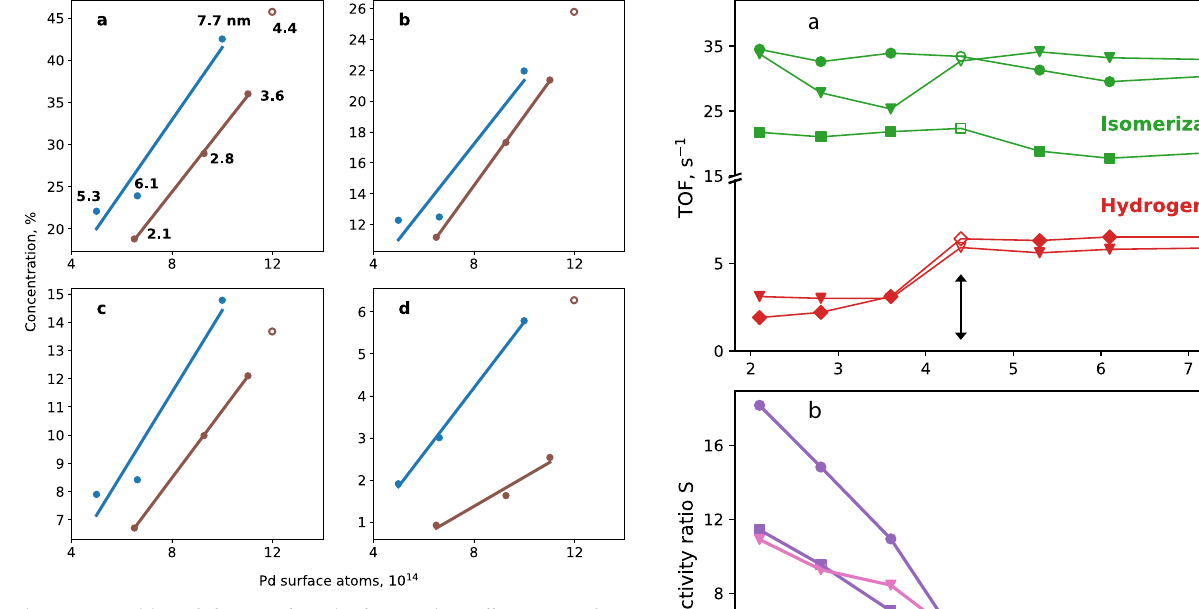
Fig. 3 Composition of the gas phase in the reaction cell at 373 K after 10 min. Isomerization and hydrogenation of 1-butene on various Pd/Al 2 O 3 / NiAl(110) model catalysts, over NPs with smooth (blue) and rough (brown) surfaces; average particle diameters (nm) indicated in panel a . Shown are the fractions (in percent) as a function of the total number of Pd surface atoms: a converted reactant 1-butene, as well as products b trans-2-butene, c cis-2-butene, and d n-butane; see also the SI. Also shown are the results for NPs of 4.4 nm diameter, in between both regimes (brown circles; see